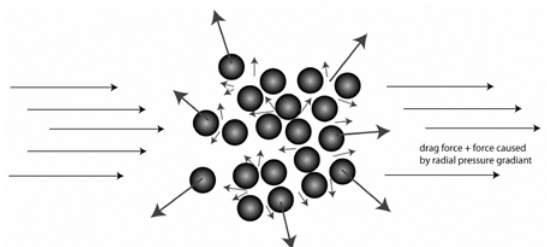
Illustration of the dispersion effect of liquid carbon dioxide. Upon release, the liquid carbon dioxide will undergo a phase transformation from a liquid to a gas resulting in an increase in volume of approximately 500 times. The rapid vaporization of liquid carbon dioxide aids in the dispersion of the powder.